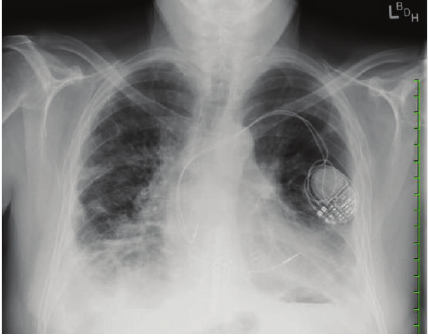
Figure 3: Chest radiography after two weeks of antifungal therapy showing right lower lobe opacity.